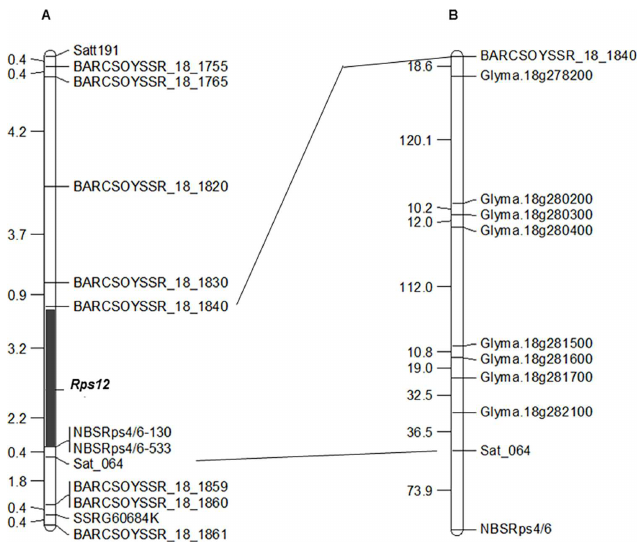
Fig 5. Physical map of NBS-LRRlike genes present on the Rps12 region. (A) Genetic map of the Rps12 region(Fig 4B). (B) Physical map of eight NBS-LRR-like genes identified from the Rps12 regionof the Williams 82